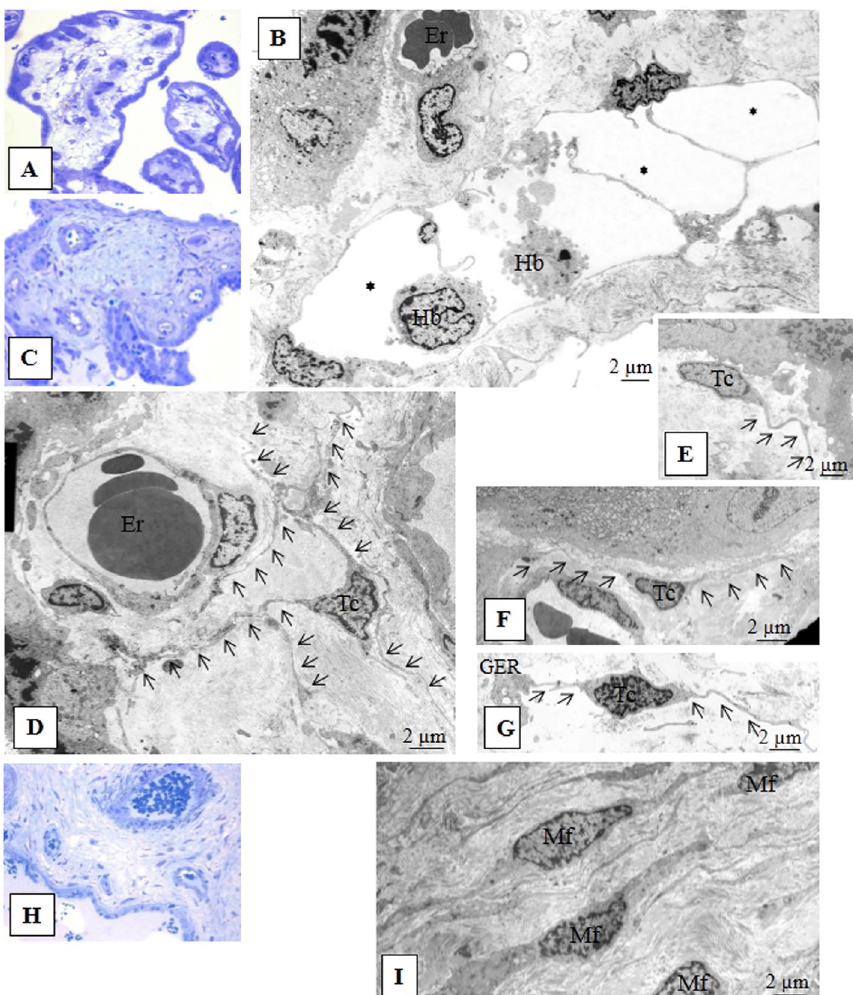
Figure 2. Morphology of villous stroma during physiological pregnancy. ( A ) Immature intermediate villi (capillaries are located peripherally and stromal channels in the centre). Semithin section, × 400 (Methylene blue staining). ( B ) Stromal channels formed by processes (telopodes) from several telocytes (average cell diameter 2.85 ± 0.6 μ m) are in the centre of the immature intermediate villus. Several thin, long telopodes (average diameter 0.23 ± 0.08 μ m) that are practically free of organelles contact one another and form a network of stromal channels in the lumen where macrophages (Hofbauer cells (Hb) are located. (Stromal channels are labelled with asterisks) White blood cells migrate from neighbouring blood vessels to the connective tissue to fulfil its macrophage functions, which is shown. A small number of granular endoplasmic reticulum cisternae were detected in the telopode dilatations only. Electron microphotograph at × 1400. ( С ) Mature intermediate villus stroma detect collagen deposits. The stromal channels are absent and blood vessels are formed. Semithin section, × 400 (Methylene blue staining). ( D ) In the stroma of a mature intermediate villus with collagen deposits, there are stellate telocytes (average diameter 2.96 ± 0.8 μ m) with 3–4 telopodes (average diameter 0.23 ± 0.1 μ m) forming a network around the blood vessels. Telopode dilatations reach more than 1.16 μ m. Electron microphotograph, × 4800. Processes of telocytes are marked with aarrows. Erythrocytes are in the lumen of the vessel (Er). ( E ) In the mature intermediate villus stroma below the basement membrane of cytotrophoblast, spindle-shaped telocytes (Tc) are present (a mean diameter of 2.65 ± 0.9 μ m) with oblong nuclei and usually 2 thin telopodes (average diameter 0.29 ± 0,1 μ m). The extended processes from these telocytes form a chain under the basement membrane. Smooth and granular endoplasmic reticulum (GER) and mitochondria are mostly located in the telopode dilatations. Electron microphotograph, × 4800. ( F ) In some fields, in the stroma of mature intermediate villi, telocytes are observed under the basement membrane of trophoblasts. Spindle/stellate cells form and more than 2 processes make contacts with the stellate telocytes located deeper. Electron microphotograph, × 4800. ( G ) Cisternae of granular endoplasmic reticulum (GER), single mitochondria, and glycogen granules located in the perinuclear zone and in telopode dilatations. Mature intermediate villus stroma. Electron microphotography, × 5600. Processes of telocytes are marked with arrows. ( H ) Stem villus. Semithin section, × 400. ( I ) In the stroma of stem villi myofibroblasts (Mf) (average diameter 2,98 ± 1,1 μ m) with 2 prolongations (average diameter 0,23- 1,16 μ m) in the arterial adventitia form a network in smooth muscle wall of blood vessels. Cisternae of well-developed granular endoplasmic reticulum locate near nucleus and in processes, small number of myofibrillae together with dense bodies reveals at the periphery of the cell (characteristics of both fibroblasts and smooth muscle cells). Electron microphotograph, ×